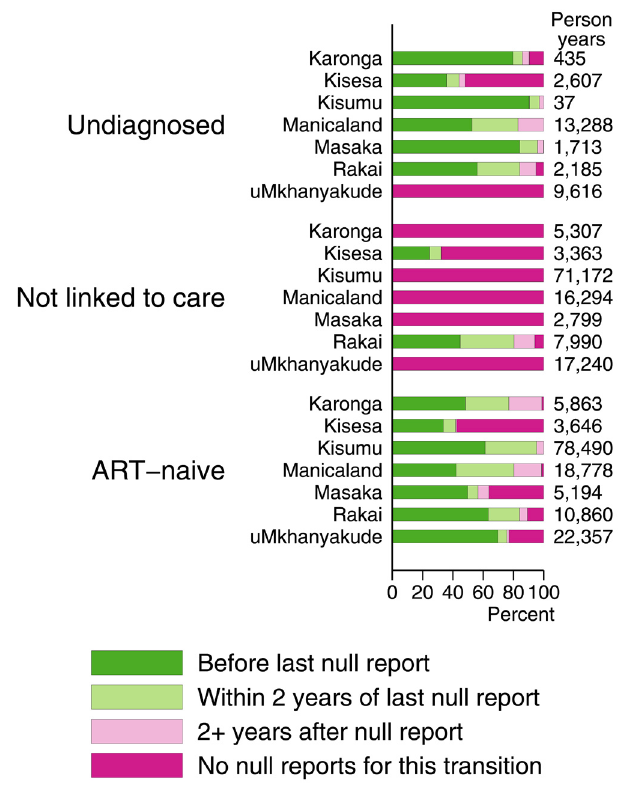
Figure 3. HIV positive person years prior to each transition along the continuum by the existence and recency of the information used to place